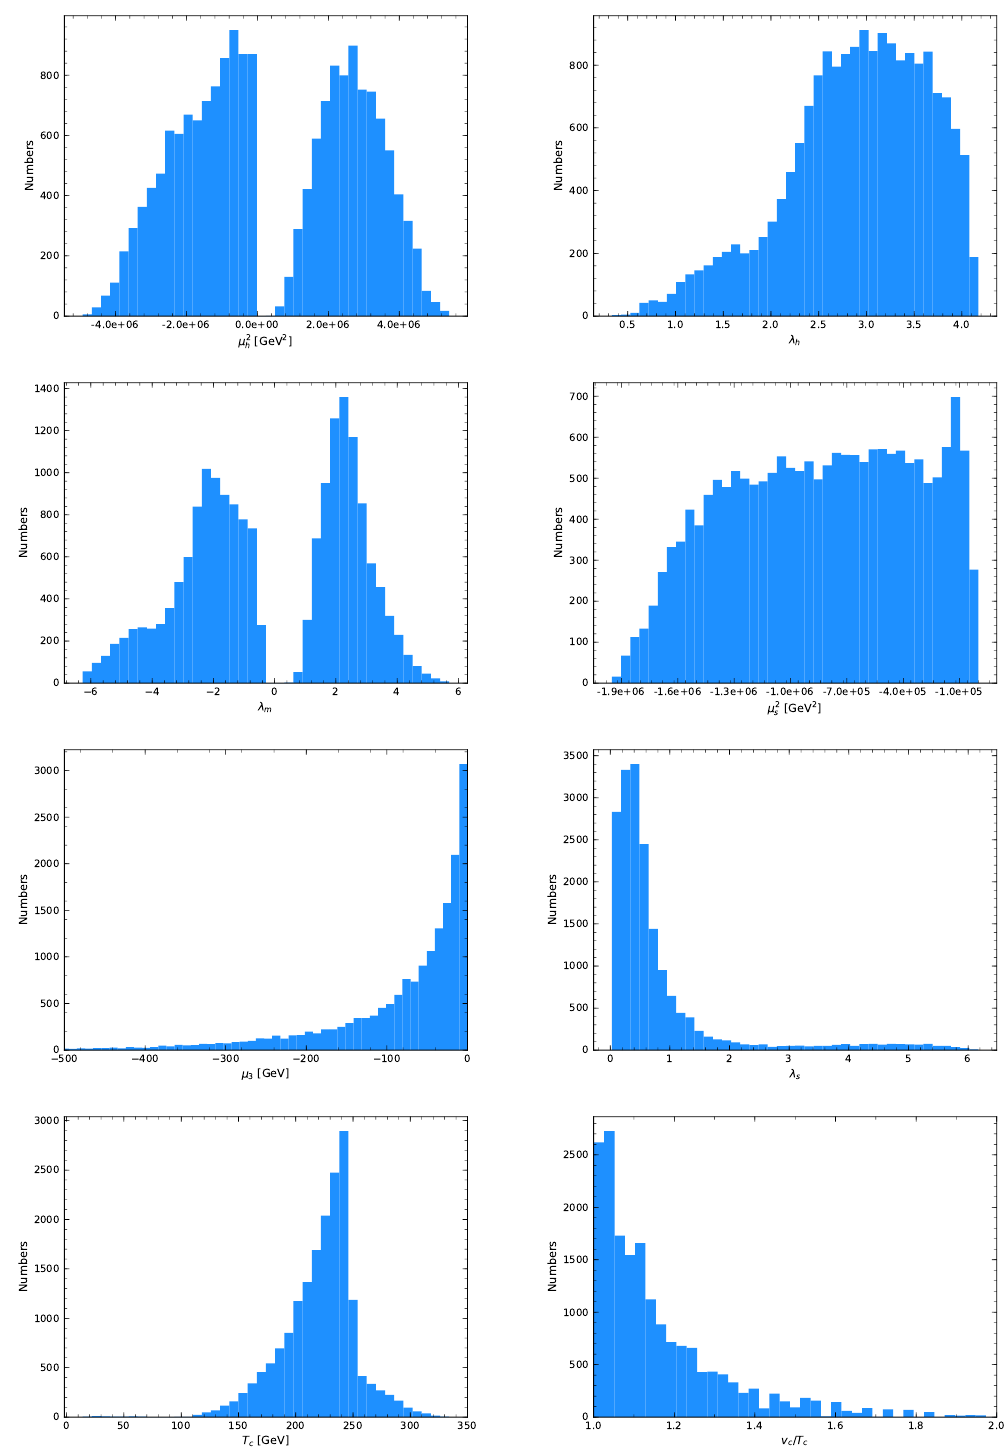
Figure 4 . Distributions of parameters in the e(cid:11)ective potential that can generate a su(cid:14)ciently strong (cid:12)rst-order EWPT. The lowest two plots give the distributions of v c =T c and T c .